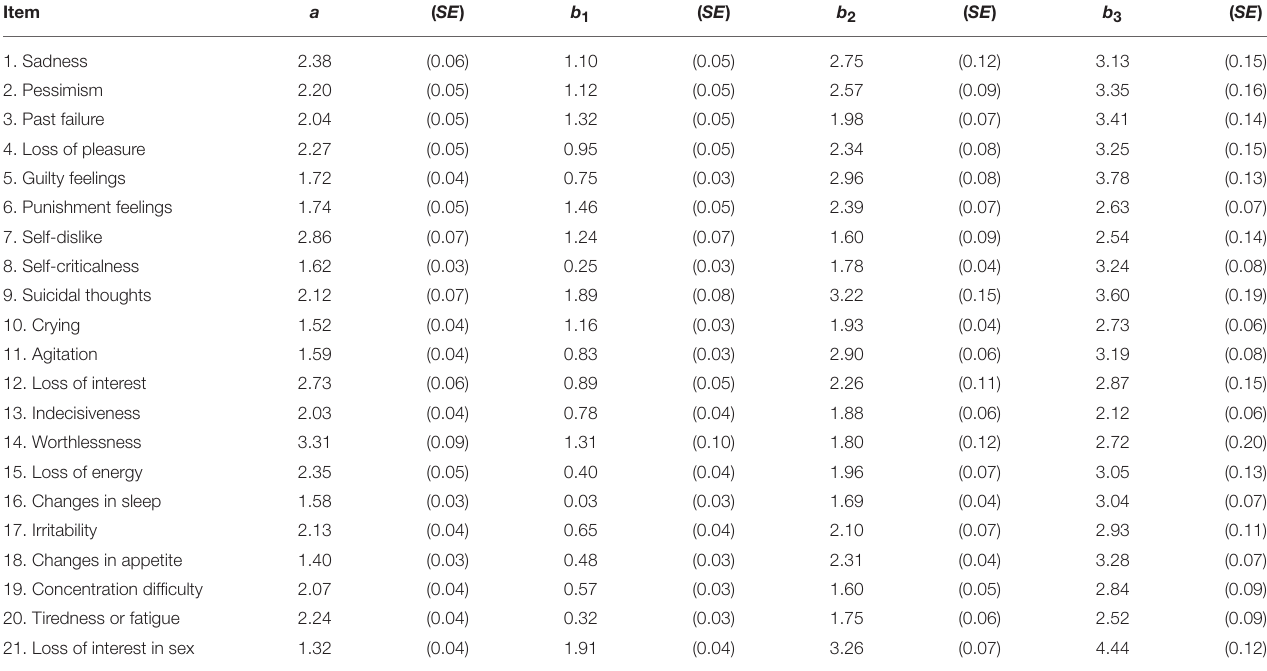
TABLE 3 | Estimated graded response model (GRM) parameters of the items of the BDI-II ( N = 12,677).